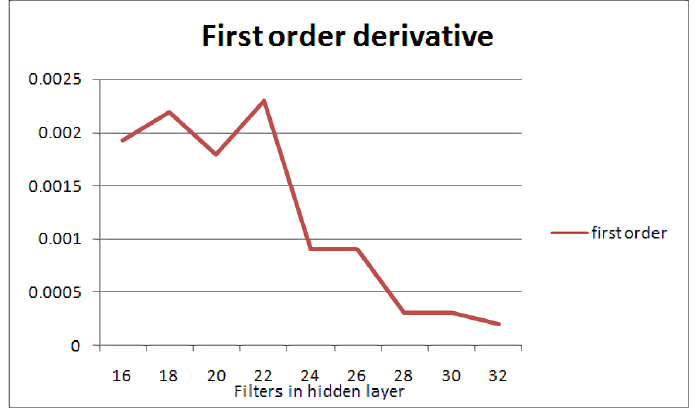
Figure 6. First-order derivative diagram of accuracy for the 1-layer convolutive NN and the MNIST dataset. A clear peak is shown at the 22-filter configuration, after which the slope decreases